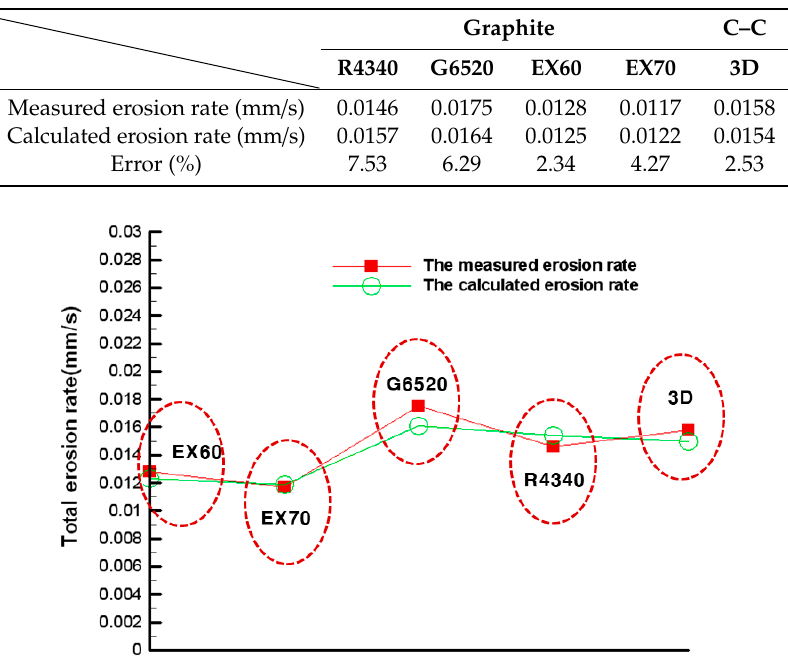
Figure 10. Comparison of the measured and calculated erosion rates of graphite and the C–C composite.